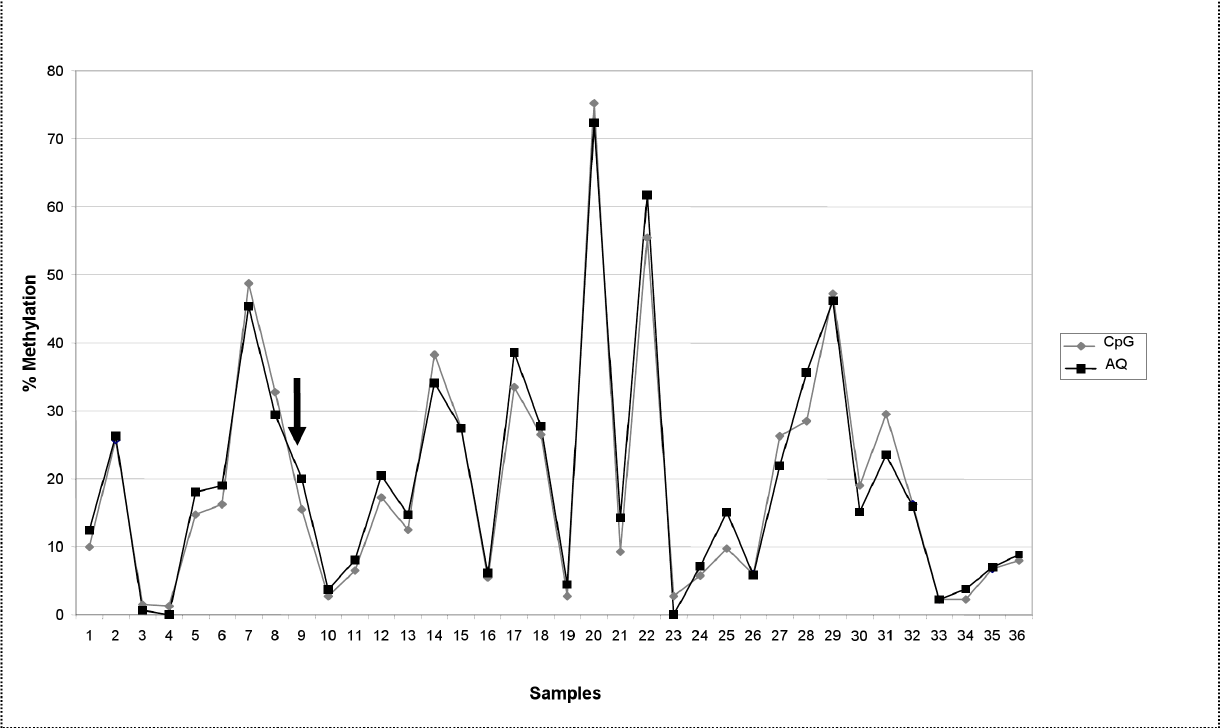
Fig 1. GSTP1 methylation analysis of DNA samples (PC study) tested in duplicate with PyroMark CpG mode and AQ mode. DNA samples (N = 36) obtained from paraffin embedded prostate tumor tissue of patients involved in “ PC study ” [24]. Mean methylation percentage of 4 CpGs in the promoter of GSTP1 gene is reported. Target sequence: 72 bp of GSTP1 promoter (Gene Bank M24485 at position 1001 – 1072); CpGs at position 1038, 1040, 1043, 1049. Deviation between paired samples ranged from 0 to 7.15%. One red score was assigned by the CpG mode to the sample indicated by the arrow. No sample has a red score assigned by the AQ